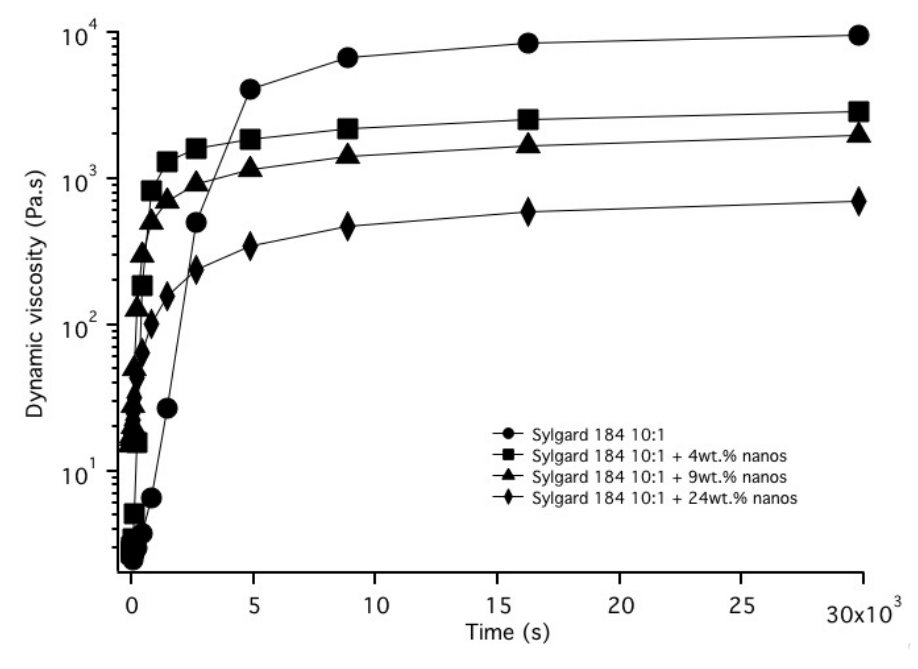
Figure 4. Dynamic viscosity versus time for Sylgard 184 reticulation without and with 4 wt %, 9 wt %, and 24 wt% of magnetic nanoparticles coated with 4–5% PDMS- co